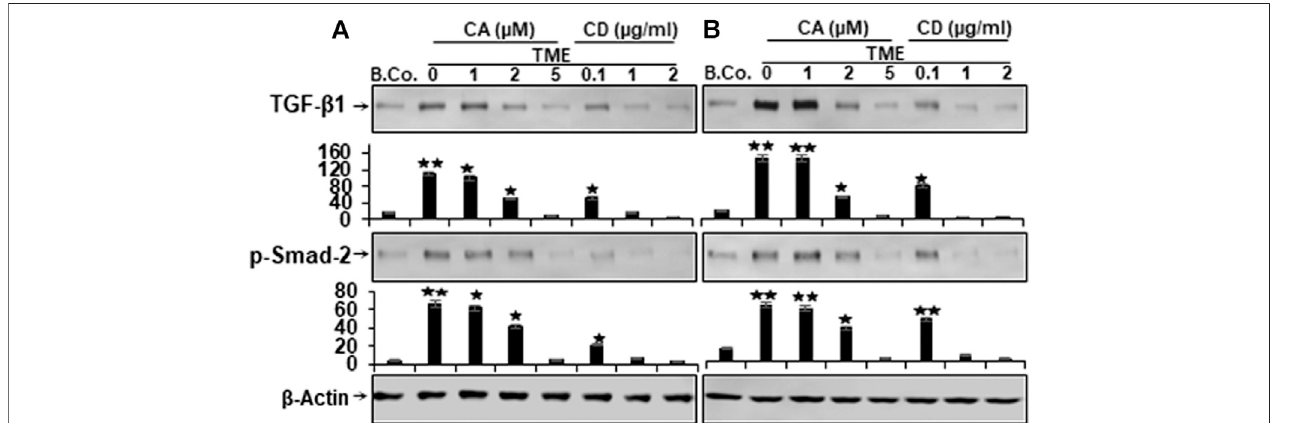
FIGURE5| CalebinAorcytochalasinDactionsonTGF- β 1andp-Smad-2expressionincolorectalcancercells. (A) HCT116and (B) RKOcellsinalginatebeads(B. Co.) orinTMEweremaintaineduntreated ortreatedasoutlinedtotheprevious.ImmunoblottingoftotalsampleswasperformedbyWestern blottingusingantibodiesto TGF- β 1 and p-Smad-2. Indicated are the results of at least three separate assays, with β -Actin serving as loading control. Densitometric analysis was performed for the indicated proteins. * p < 0.05, ** p < 0.01 relatively to basal control.